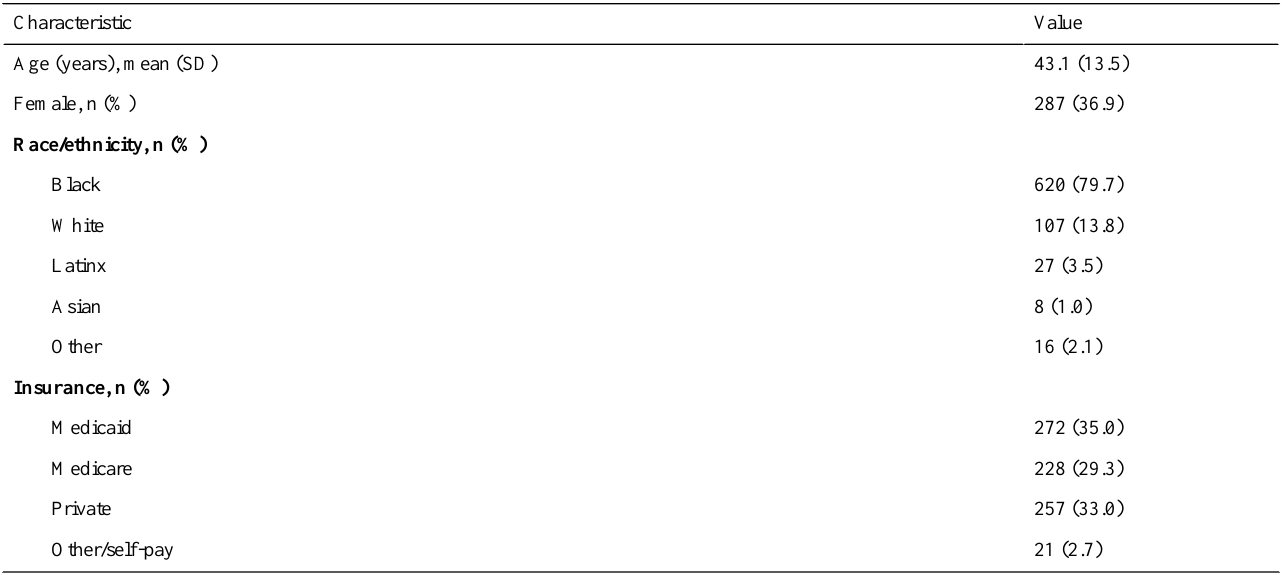
Table 1. Demographic characteristics of participants